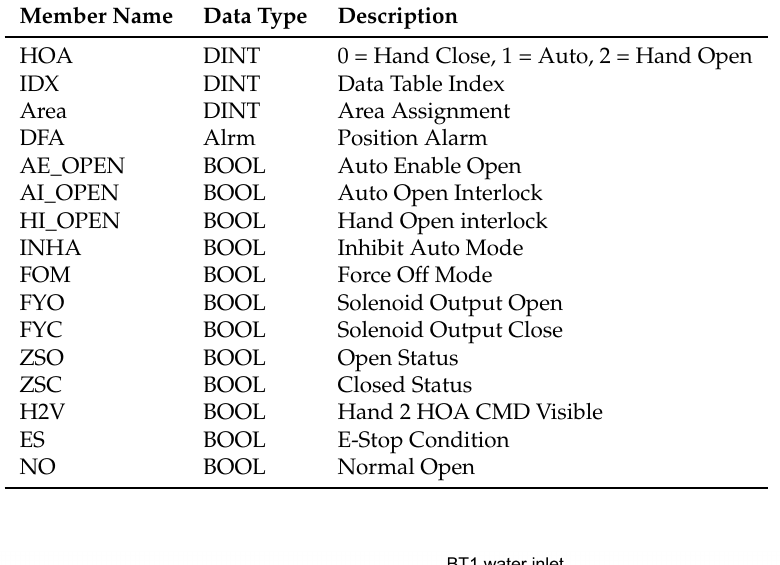
Table 1. User-defined data type for a two-way valve, original program.